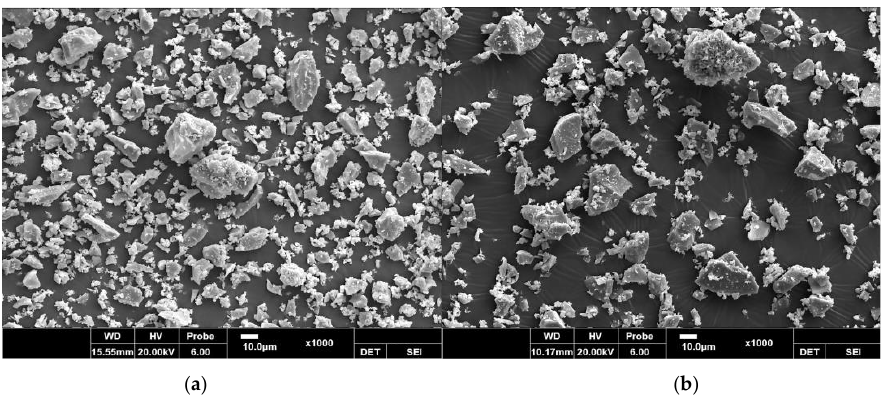
Figure 1. Particle size distribution of ordinary Portland cement (OPC) and ground granulated blast- furnace slag (GGBS).